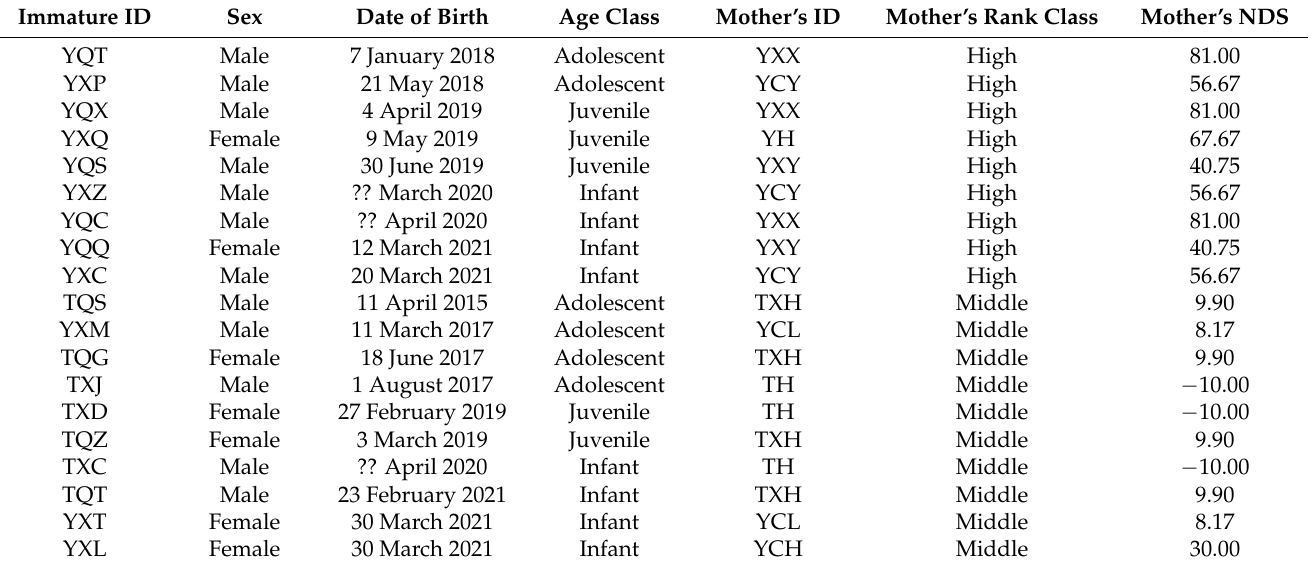
Table 1. Immature individuals in group YA1 during the study